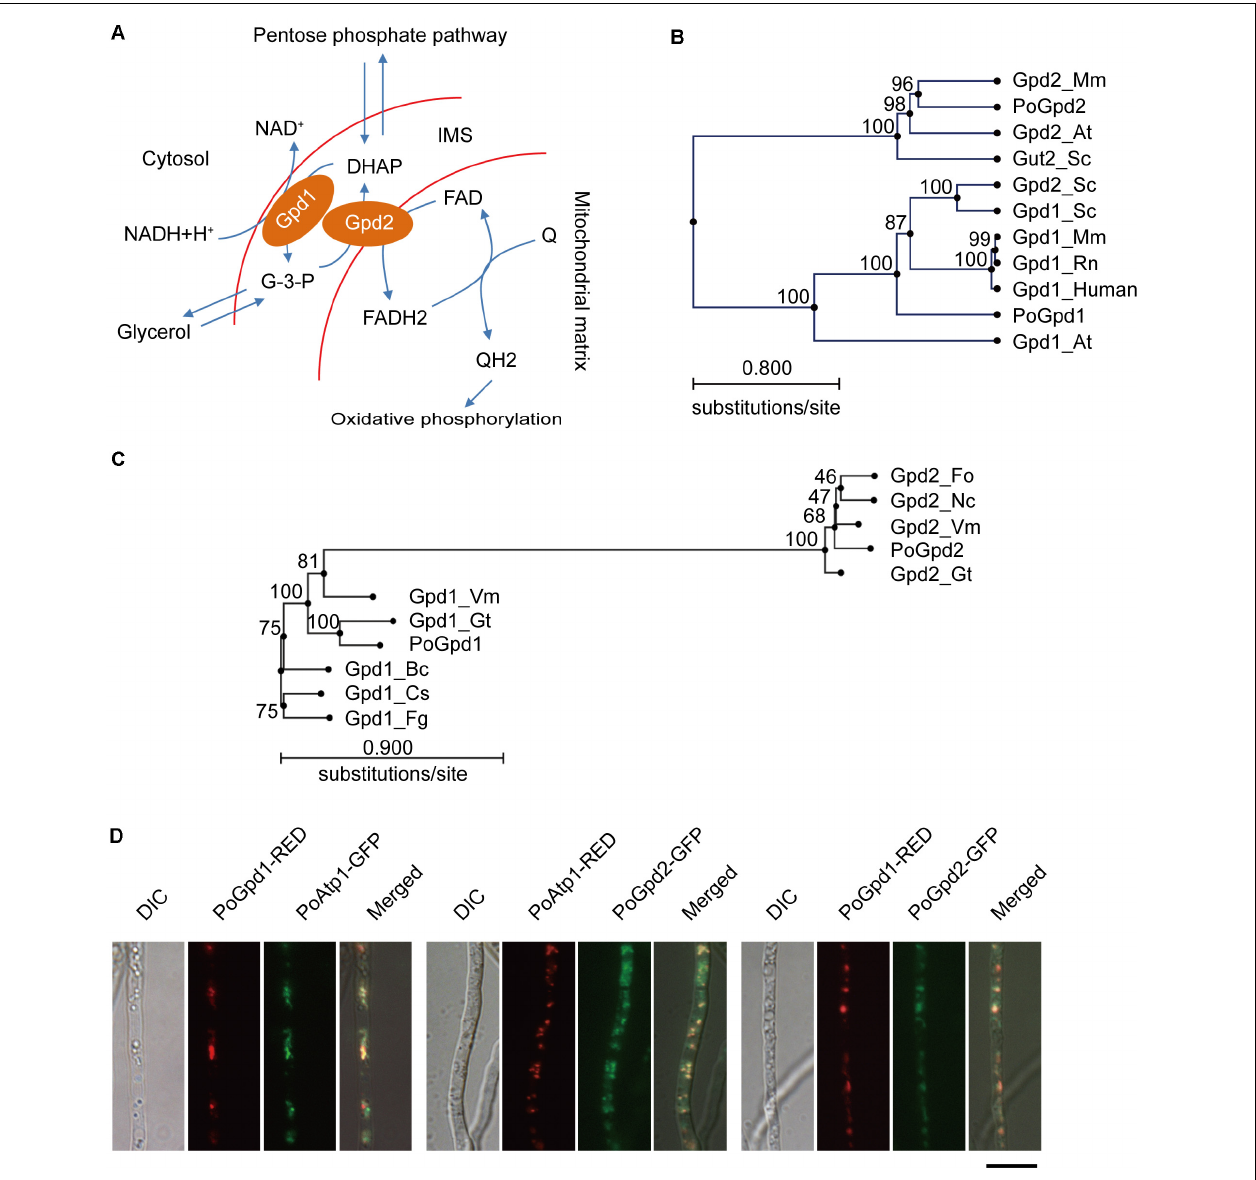
FIGURE 1 | Glycerol-3-phosphate dehydrogenases in Pyricularia oryzae . (A) Glycerol-3-phosphate shuttle pathway in P. oryzae . PoGpd1 and PoGpd2 are Glycerol-3-phosphate dehydrogenase 1 and 2. DAHP, dihydroxyacetone phosphate. FAD, flavin adenine dinucleotide. Q, coenzyme Q. (B) Phylogenetic tree (Neighbor-Joining) of PoGpd1 and PoGpd2 homologs in different organisms constructed using CLC Main Workbench 5.5. The PoGpd1 and PoGpd2 homologs were Gpd1_Mm (NP_034401.1) in Mus musculus , Gpd1_Rn (NP_071551.2) in Rattus norvegicus , Gpd1_human (NP_005267.2) in human, Gpd1_At (O22216.1) in Arabidopsis thaliana , Gpd1_Sc (CAA54189.1) in Saccharomyces cerevisiae , Gpd2_Sc (NP_014582.1) in S. cerevisiae , Gpd2_Mm (NP_034404.3) in M. musculus , Gpd2-At (Q9SS48.1) in A. thaliana , and Gut2_Sc (CAA50652.1) in S. cerevisiae . The numbers at branch nodes are the bootstrap values. (C) Phylogenetic tree (Neighbor-Joining) of PoGpd1 and PoGpd2 homologs in different fungi. The PoGpd1 and PoGpd2 homologs were Gpd2_Gt (XP_009227424.1) in Gaeumannomyces tritici , Gpd2_Vm (KUI73636.1) in Valsa mali , Gpd2_Fo (EWZ35447.1) in Fusarium oxysporum , Gpd2_Nc (XP_963445.2) in Neurospora crassa , Gpd1_Fg (XP_011323505.1) in Fusarium graminearum , Gpd1_Gt (XP_009225248.1) in G. tritici , Gpd1_Vm (KUI66172.1) in V. mali , Gpd1_Bc (CCD43082.1) in Botrytis cinerea , Gpd1_Cs (KXH24909.1) in Colletotrichum salicis . (D) Subcellular localization of PoGpd1 and PoGpd2 in mitochondria of P. oryzae hyphae. Both PoGpd1-RED and PoGpd2-GFP fusion protein were co-localized with an alpha subunit of mitochondrial F1F0 ATP synthase PoAtp1. Bar = 10 µ